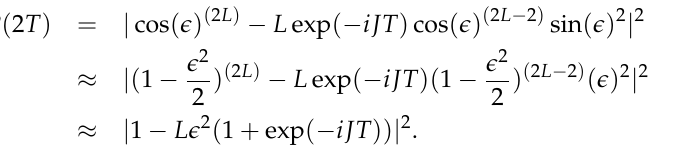
Figure 2. The Fourier transform of the stroboscopic return probability, P ( 2 nT ) for a 10-site chain with ( a ) JT = π and ( b ) JT = π . As exemplified by the case of JT = π 2 ( n ∗ is the DTC lifetime defined below Equation (3)). These oscillations result in a splitting of the ω /2 Fourier